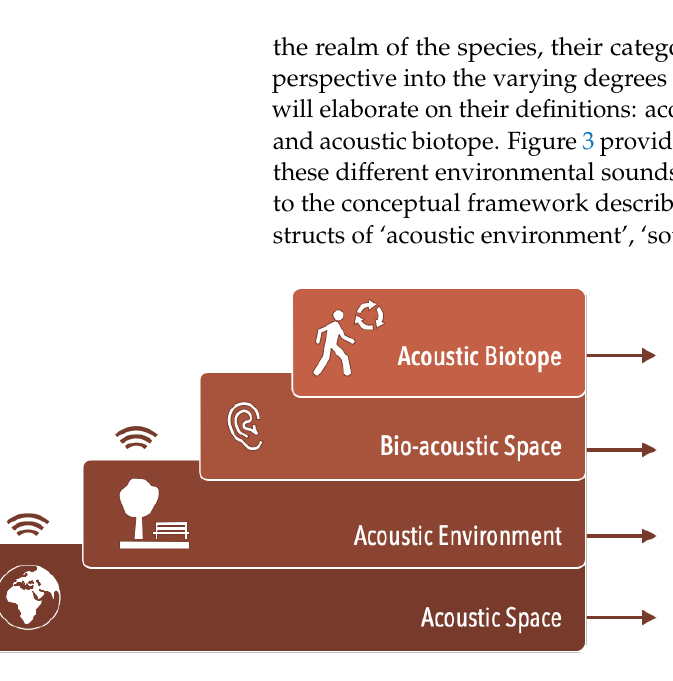
Figure 3. The relationship between the entire acoustic space which encompasses all possible sounds and acoustic biotope which encompasses sounds that can be captured by species in a functional living environment and are directly related to the species.